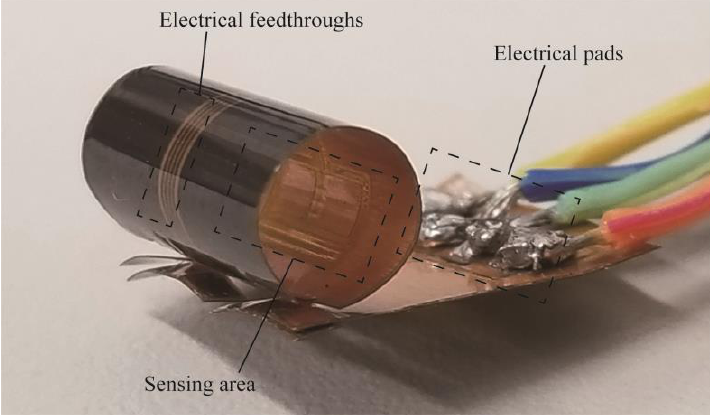
Figure 1. Photograph of a tube-type flow sensor previously fabricated using COP substrate. The flow measurement element was installed on the inner wall of the tube.